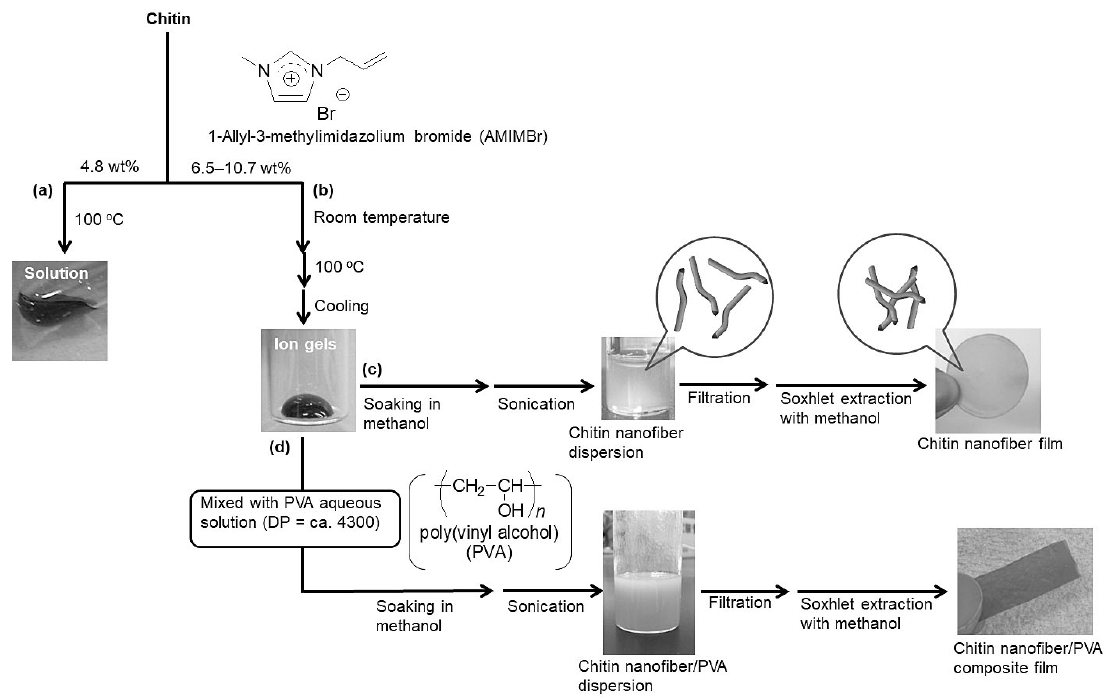
Figure 4. ( a ) Dissolution and ( b ) gelation of chitin with AMIMBr and preparation of ( c ) self-assembled ChNF dispersion/film and ( d ) ChNF/PVA composite film (reprinted with permission from ref. [27]. Copyright 2020, Elsevier).